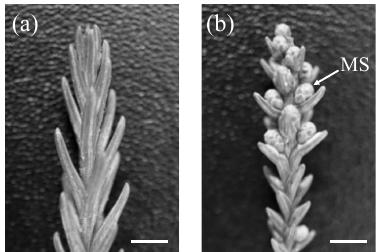
Figure 1. Morphology of the shoot top of Cryptomeria japonica : ( a ) nontreated control sample at 6 weeks (CT_6 w); ( b ) GA3-treated sample at 6 weeks (GA_6 w). Male strobili (MS; indicated by arrow) are formed at the axil of the shoot. Forests 2020 , 11 , x FOR PEER REVIEW